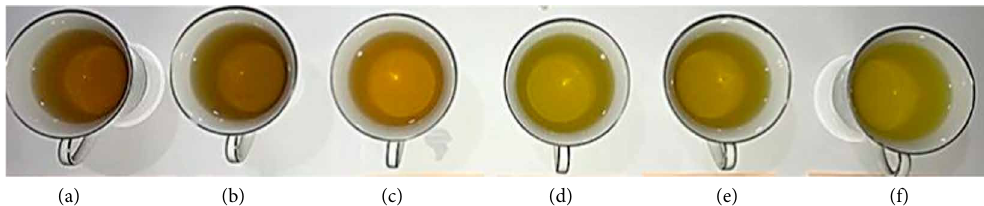
Figure 3: Brew colours of the unblanched Moringa samples dried at (a) 55°C, (b) 60°C, (c) 65°C and steam blanched Moringa samples dried at (d) 55°C, (e) 60°C, (f)